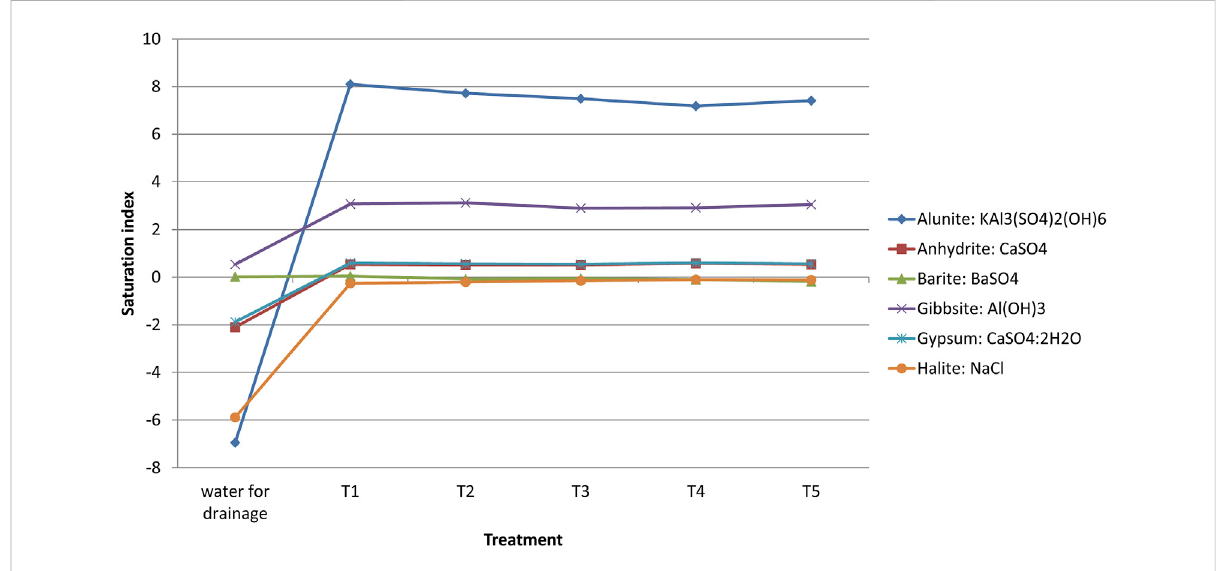
FIGURE 7 Saturation index of Sed El Masjoune soil leached